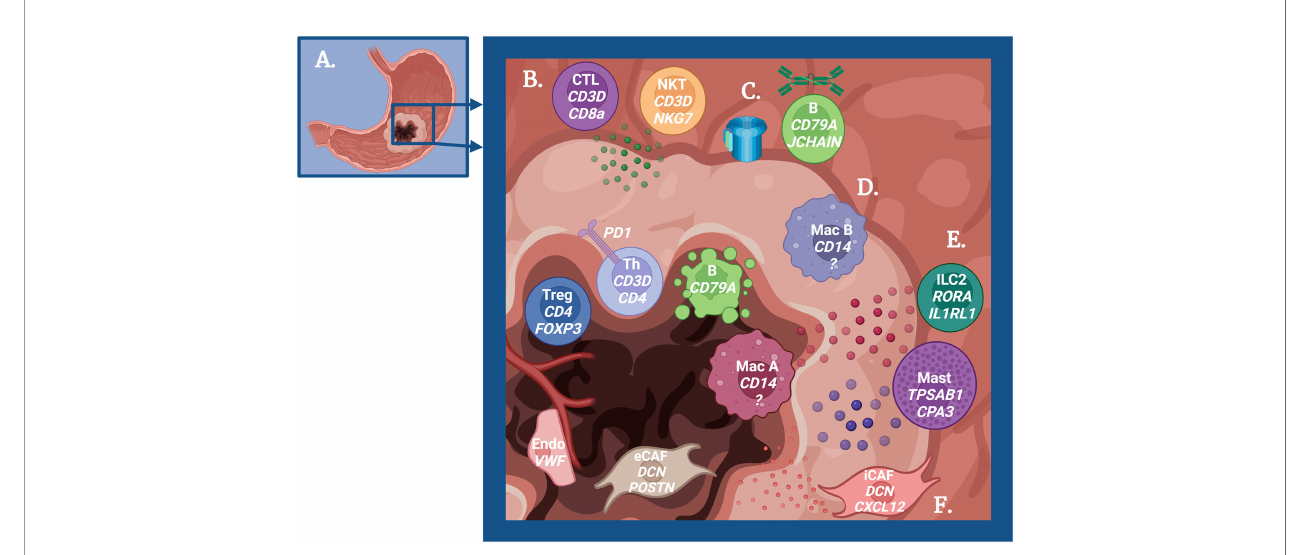
FIGURE 1 | Schematic overview of the immune-mediated mechanisms in gastric carcinogenesis. (A) Cartoon depicting a stomach with gastric adenocarcinoma. (B) Role of T cells in tumor immunity. Peripheral Cytotoxic T cells (CTL) and Natural Killer T cells (NKT) produce granzyme to promote antitumor immunity, but regulatory T cells (Treg) and exhausted T helper cells (Th) are dominant near the tumor center. (C) Role of B cells in tumor immunity. B cells promote antitumor immunity via IgA production and complement activation early in the pathogenesis, but these B cells undergo apoptosis as cancer progresses. (D) Role of macrophages in tumor immunity. Some macrophages (M1-like) promote antitumor immunity, while other macrophages (M2-like) promote tumor growth. (E) Role of ILC2s and mast cells in tumor immunity. The cytokine IL-13 produced by ILC2s and mast cells may promote tumor progression and act on tumor-promoting macrophages. Mast cells also produce histamine, which has a potential role in cancer progression. (F) Role of fi broblasts and endothelial cells in tumor immunity. In fl ammatory cancer-associated fi broblasts (iCAF) regulate immune cells to support tumor growth, while epithelial to mesenchymal CAFs (eCAF) directly promote tumor growth. Endothelial cells similarly play a role in immune regulation to increase metastatic potential. Created with